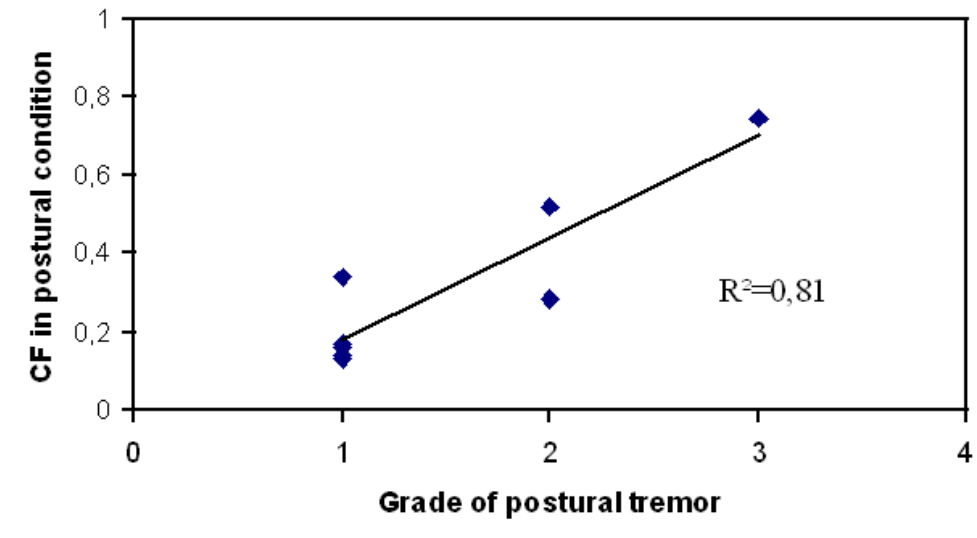
Figure 8. Correlation between the clinical grade of postural tremor and crest factor obtained with accelerometry during a postural task in a group of eight patients presenting a neurological tremor. Accelerometer fixed on the extremity of the index finger. Sampling rate: 512 Hz, duration of acquisition: 30